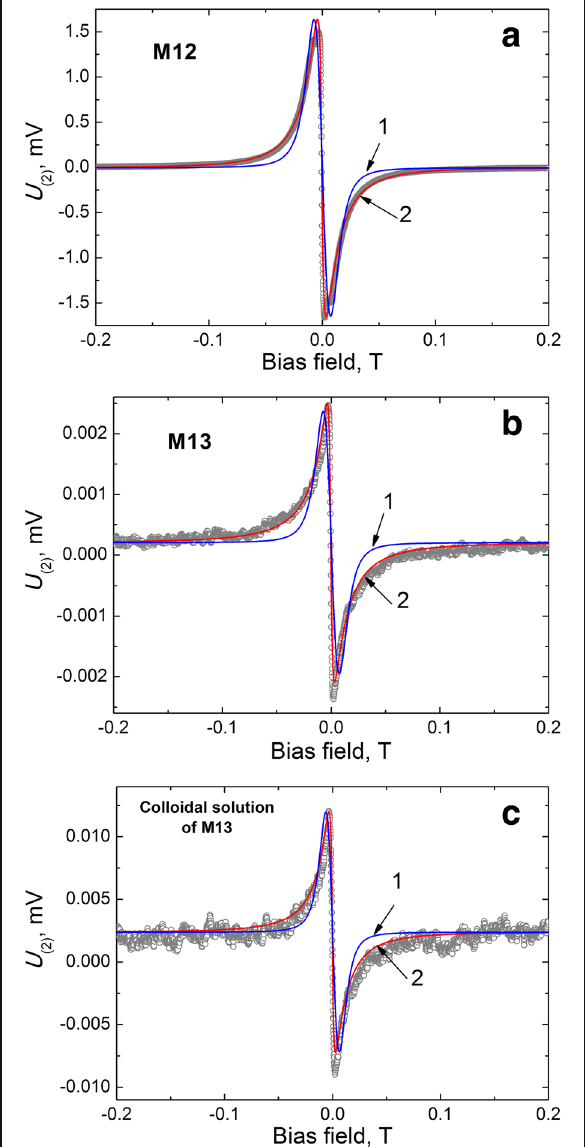
Fig. 3 Magnetic field dependencies of the response signal 2nd harmonic ( open dots ) of the sample M12 ( a ), M13 ( b ) and colloidal solution of M13 ( c ) and fit by (4) ( blue curve 1 ) and (7) ( red curve 2